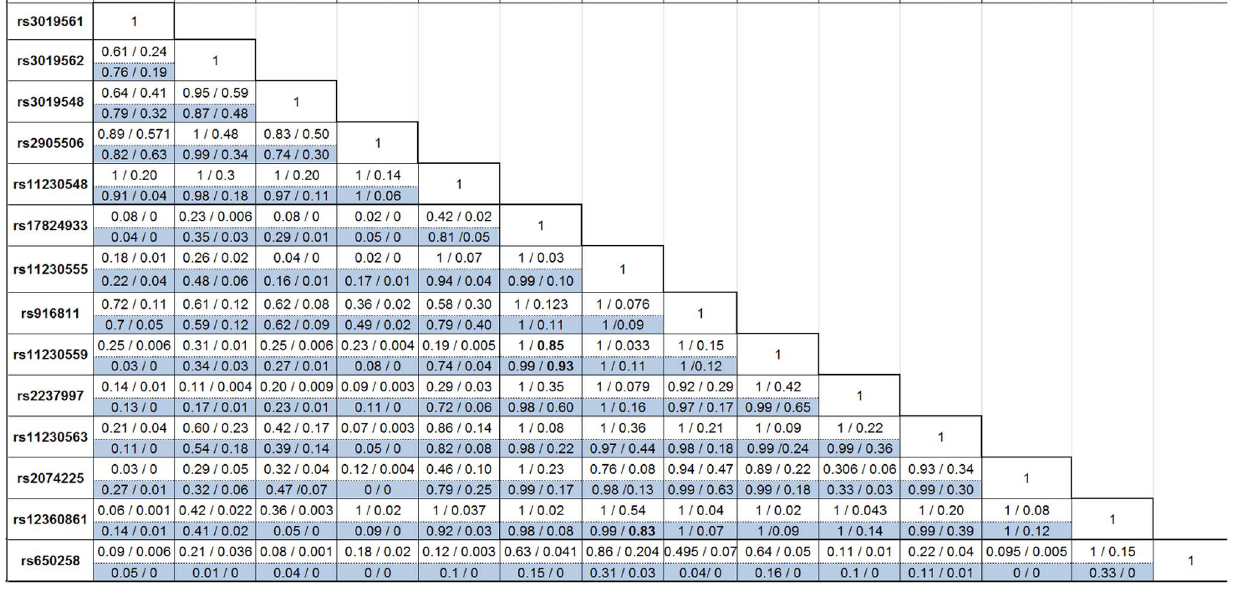
Figure 2. LD values ( D ’/ r 2 values) between each of the 14 SNP markers genotyped in the Spanish-Basque population. The figure represents a comparison of the LD values between the 14 SNPs genotyped in the northern Spanish-Basque population ( D ’/ r 2 values) using the values from the CEU 1000 genomes project and from the data generated from the Spanish-Basque population (823 cases/814 controls). The values in white are the D’ / r 2 values from the CEU 1000 Genomes Project, while the blue-shaded ones are generated for the northern Spanish-Basque dataset using Haploview software (version 4.2).